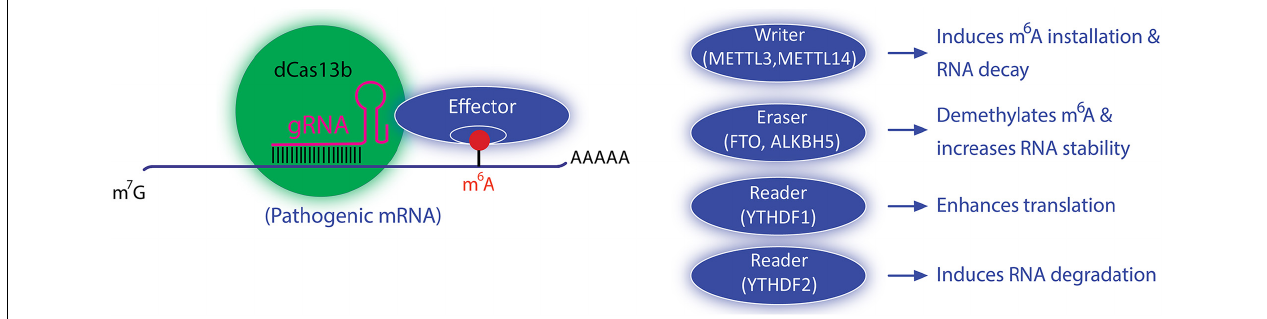
FIGURE 4 | Schema showing application of clustered regularly interspaced short palindromic repeats (CRISPR)–dCas13 for N 6 -methyladenosine (m 6 A) editing. The m 6 A editing system is made by fusing deactivated Cas13b (dCas13b) with a guide RNA (gRNA) that can specifically target abnormally methylated messenger RNA (mRNA) (pathogenic mRNA) and coupling of CRISPR–dCas13 to an m 6 A factor to effect desired changes in m 6 A modification. Depending on the effector used, it is possible to induce m 6 A deposition, removal, or recognition (binding/reading), leading to the induction of degradation, translation enhancement, or increased stability of the target